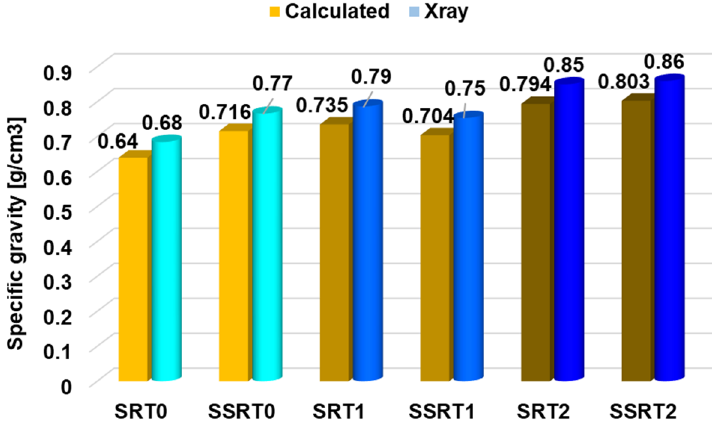
Figure 7. Comparison of conventional density (calculated) and density determined with X-ray equipment.